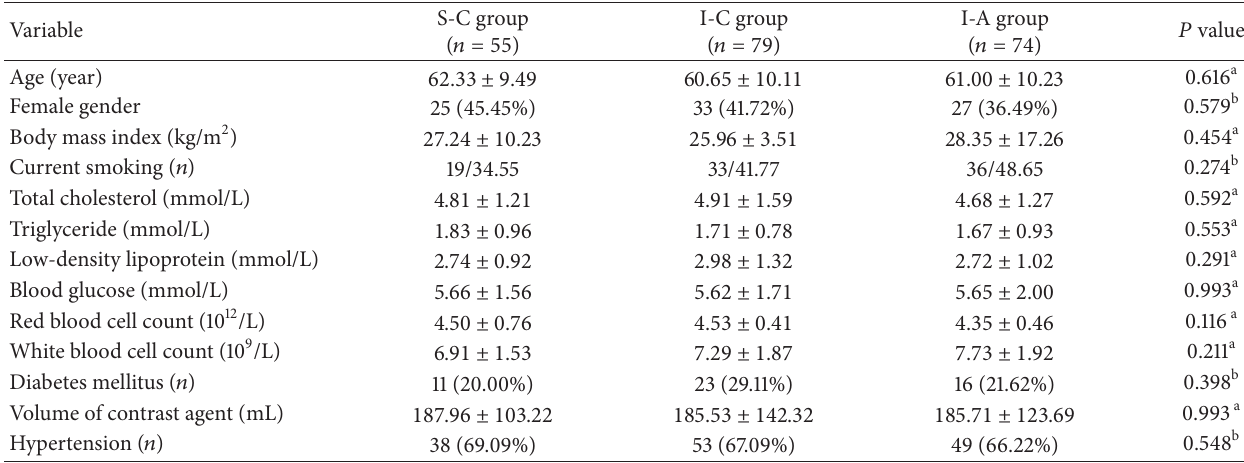
Table 1: Baseline clinical, biochemical and procedural characteristics of the